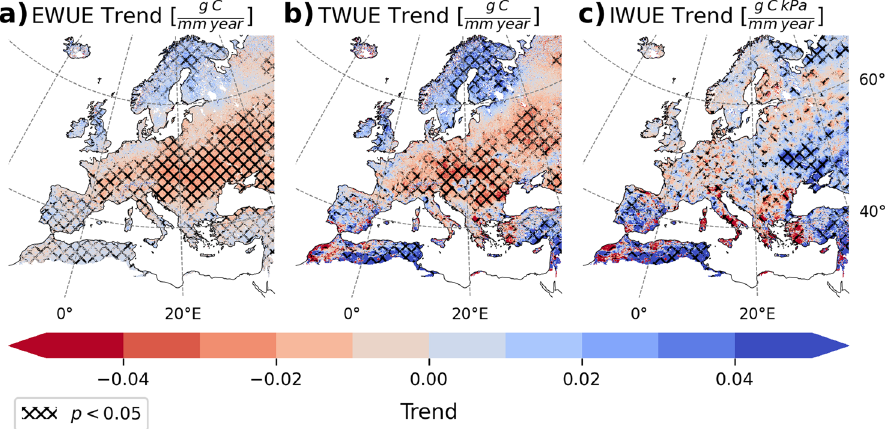
Fig. 1 Albeit different directionality of trends elsewhere, all indices agree on decreasing summer WUE in Central Europe. In the summer seasons (June, July and August) over the years 1995 – 2018, EWUE ( a ), TWUE ( b ) and IWUE ( c ) trends were calculated over monthly time series for each grid cell with the seasonal Mann-Kendall analysis. The cross hatches mark areas where the trends are signi fi cant ( p < 0.05).